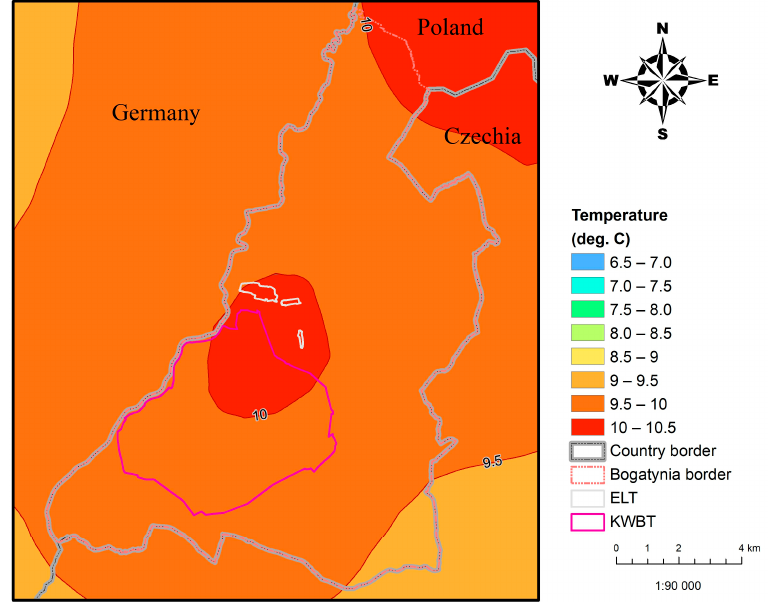
Figure 11. Spatial distribution of annual mean air temperature values determined by WRF/CALMET